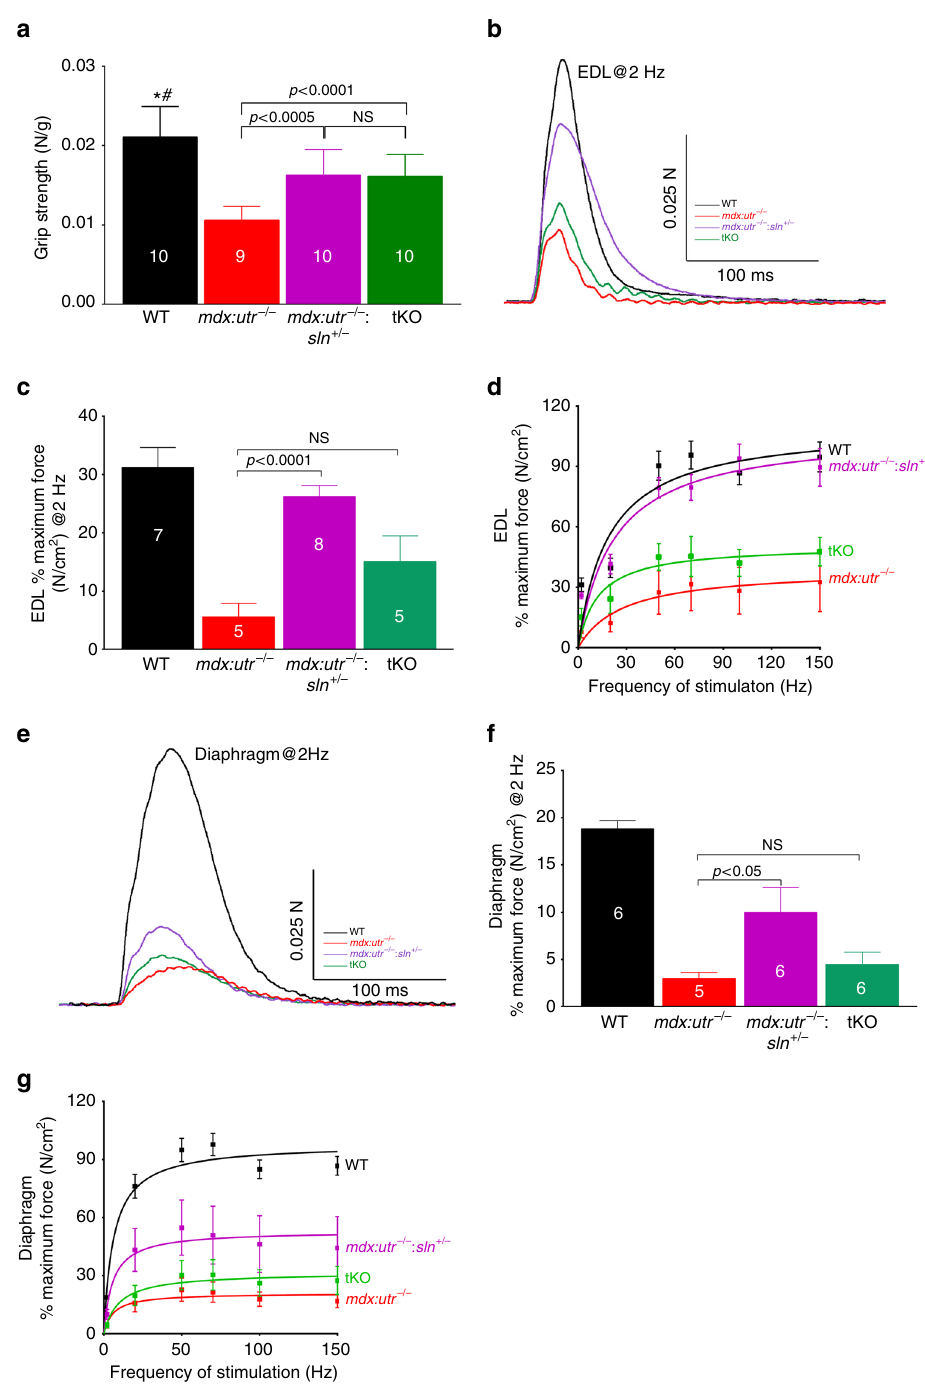
Fig. 4 Reduction in SLN expression improves skeletal muscle function in mdx:utr − / − mice. a Forelimb strength measured using a grip strength meter shows improved muscle strength in the mdx:utr − / − :sln + / − and tKO mice. We used 3 – 4 month old male and female mice for this study. The n number for each group is shown within the bar. Data are presented as mean ± SEM ( t -test with Welch ’ s correction). # p < 0.0001 vs. mdx:utr − / − . * p < 0.05 vs. mdx:utr − / − : sln + / − and tKO mice. b , e Representative traces of twitch force at 2 Hz for EDL and hemidiaphragm respectively. c , f The maximum force generated by the EDL and hemidiaphragm at 2 Hz are signi fi cantly increased in the mdx:utr − / − :sln + / − mice compared to that of mdx:utr − / − mice. The n number for each group is shown within the bar. Data are presented as mean ± SEM. d , g Force-frequency curves indicating that force generated by EDL and hemidiaphragm in the mdx:utr − / − :sln + / − mice are signi fi cantly increased at all frequencies. EDL and hemidiaphragm are from 3 to 4 month old